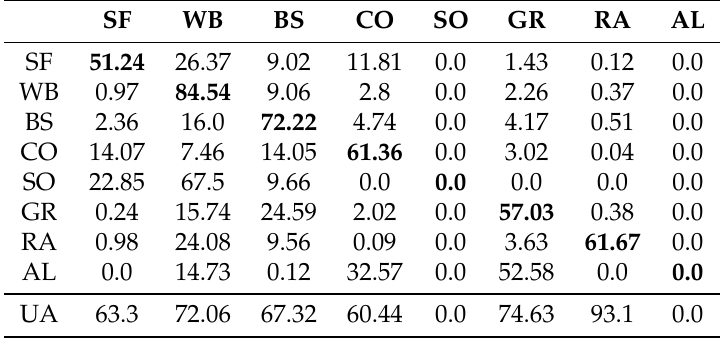
Table 10. Confusion matrix for 24-03-2015 using Landsat8 (7 images). κ = 0.61.